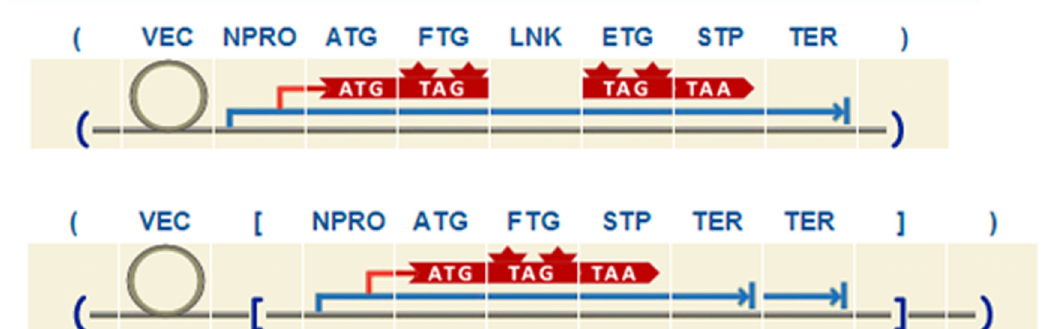
Fig 2. Example of two different designs for promoter analysis studies. A. The expression cassette includes a FTG under the control of a NPRO and fused with an ETG by means of a LNK. B. The expression cassette has reverse orientation and double TER.